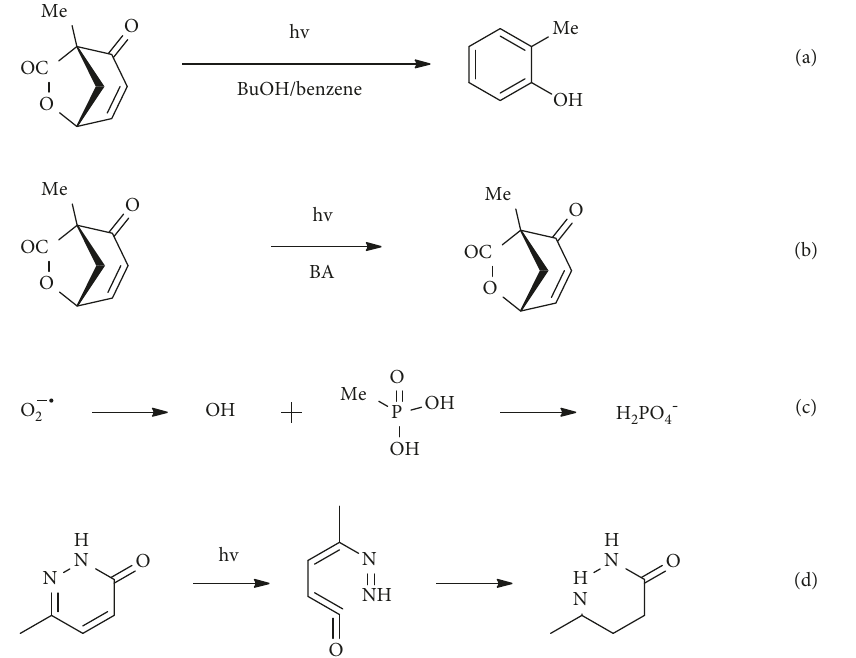
Figure 6: Degradation mechanism of plant growth